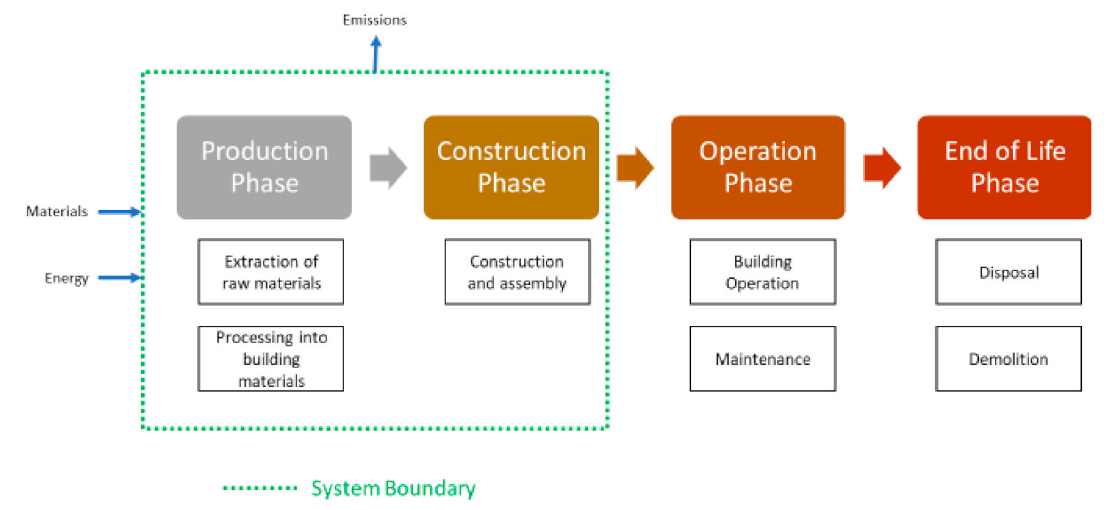
Figure 1. System boundaries of the proposed study.